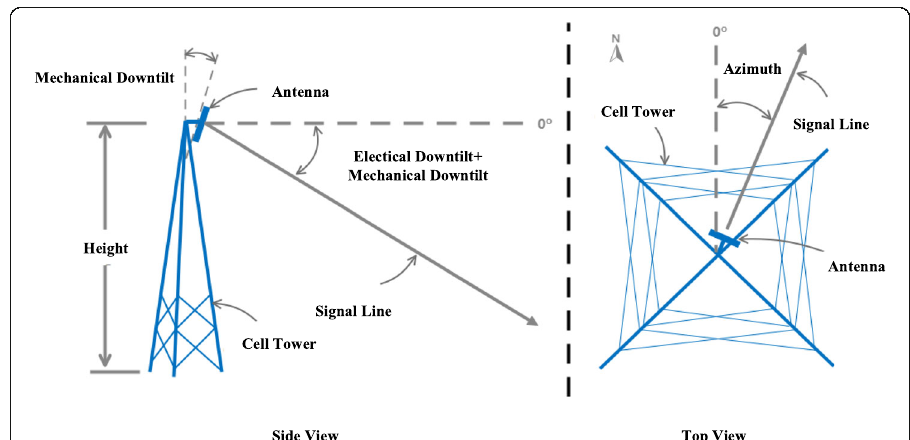
Fig. 2 The meaning of engineering parameter